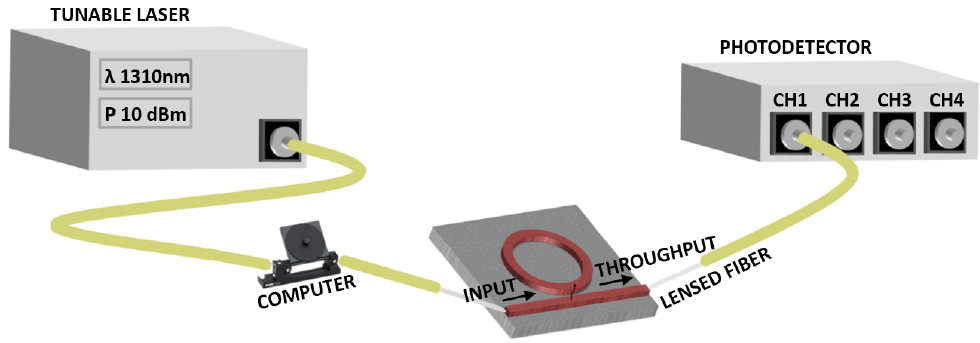
Figure 3. Schematic configuration of the experimental